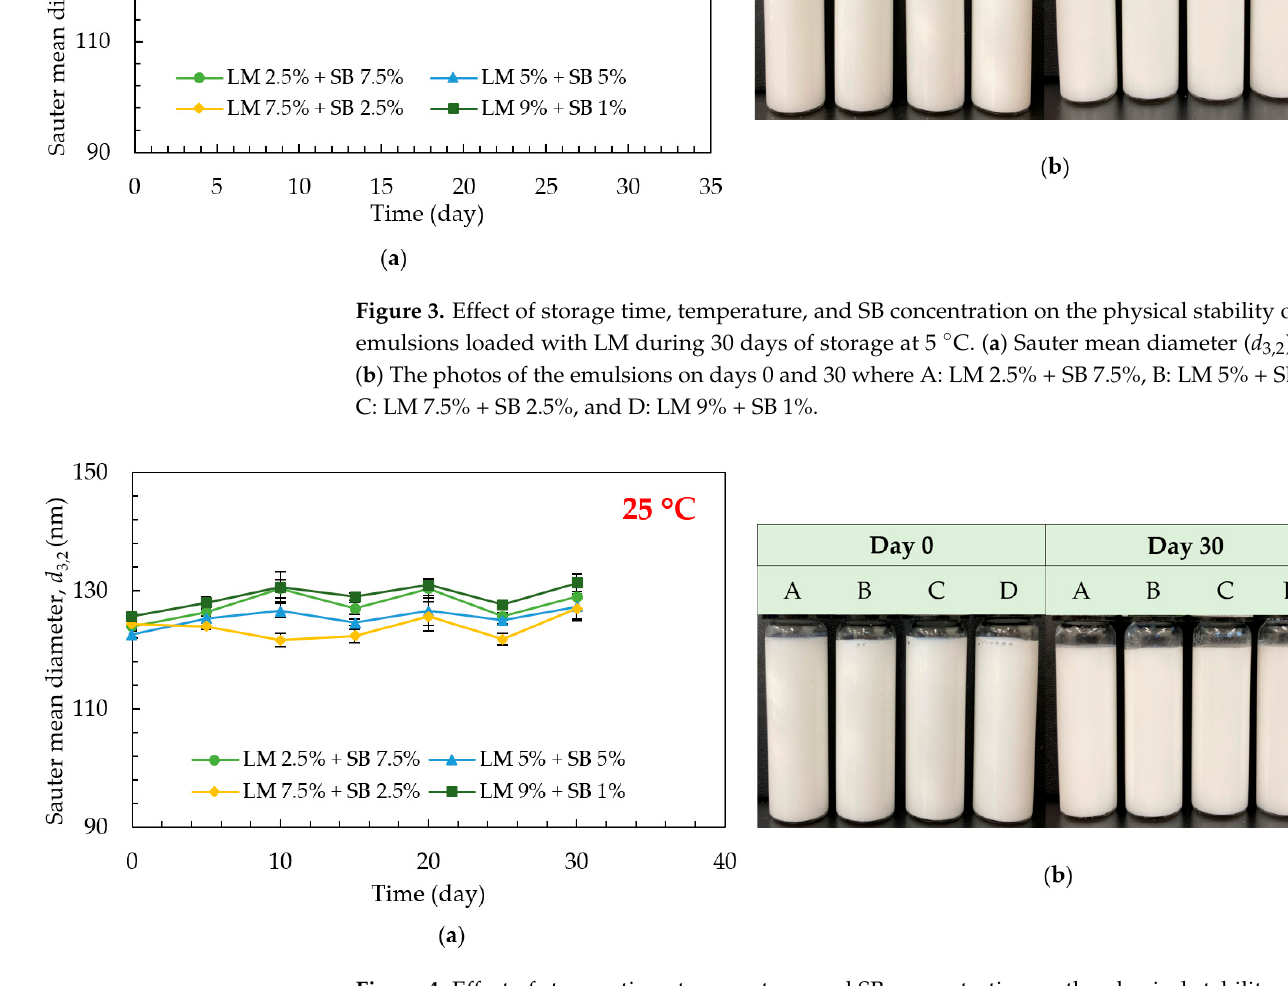
Figure 5. E ff ect of storage time, temperature, and SB concentration on the physical stability of the emulsions loaded with LM during 10 days of storage at 50 °C. ( a ) Sauter mean diameter ( d 3,2 ) and ( b ) The photos of the emulsions on days 0 and 10 where A: LM 2.5% + SB 7.5%, B: LM 5% + SB 5%, C: LM 7.5% + SB 2.5%, and D: LM 9% + SB 1%. 3.5. Chemical Stability of LM-Loaded Emulsions over Time under Di ff erent Temperatures The chemical stability of LM-loaded emulsions was evaluated based on the emulsi fi - cation e ffi ciency to retain LM till the end of the experimental storage period (30 days) at di ff erent temperatures (5 and 25 °C). For that purpose, LM concentration was measured before and after the emulsi fi cation process to determine the initial concentration in our experiment. It was found that about 70–80% of LM remained after the emulsi fi cation process in all the samples (A, B, C, and D), indicating some reduction during emulsion preparation. The emulsion with the lowest LM concentration (sample A) was noticed to have the highest reduction in its LM value. In contrast, the emulsion with the highest LM concentration (sample D) showed the lowest reduction in the LM value. Essential oils are known for their sensitivity to the high shear